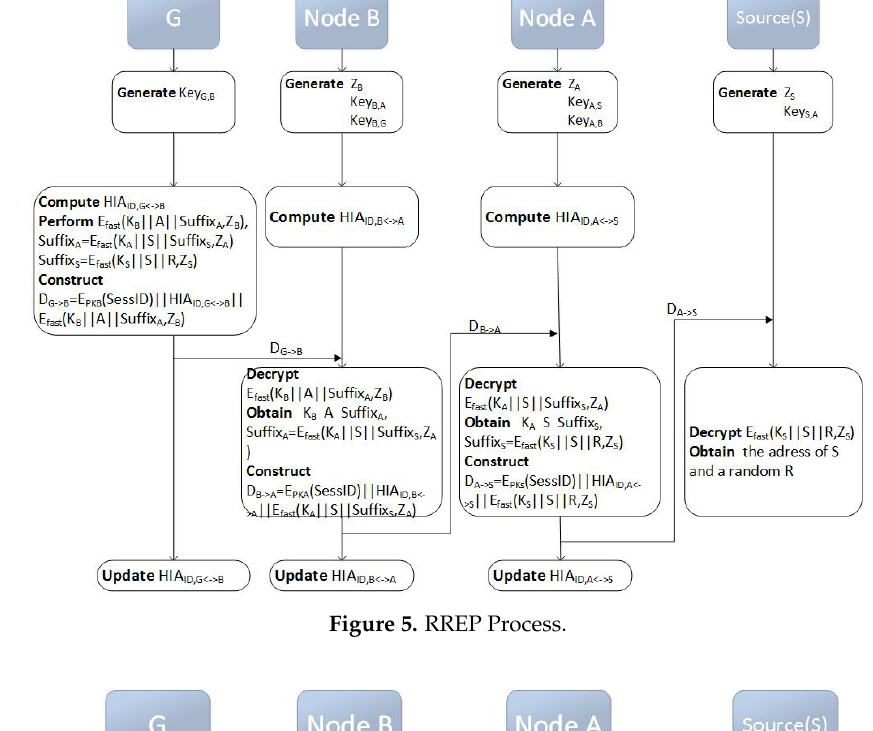
Figure 5. RREP Process.